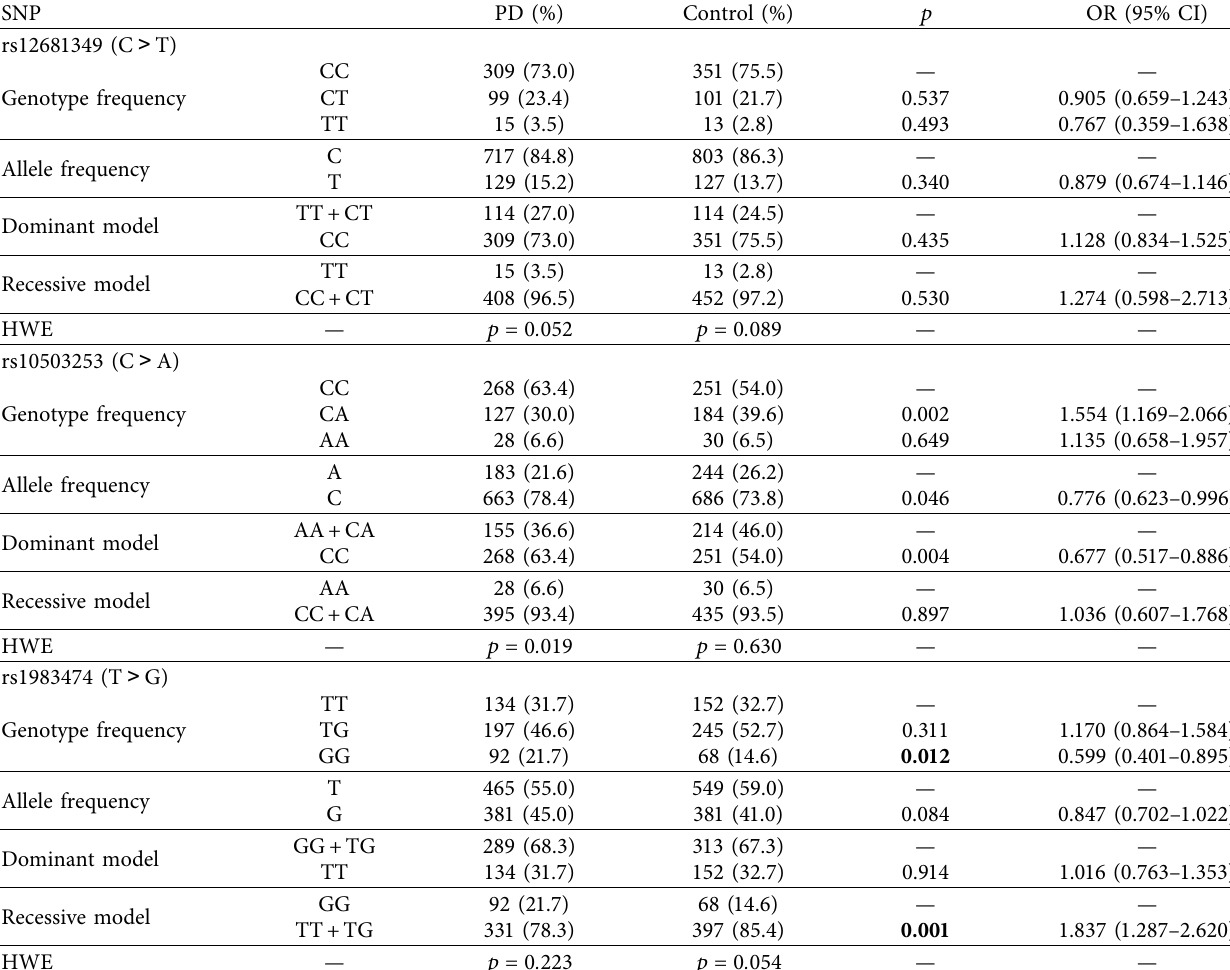
Table 3: Distributions of genotypes and alleles at rs12681349, rs10503253, and rs1983474 among Chinese with PD patients and healthy controls.